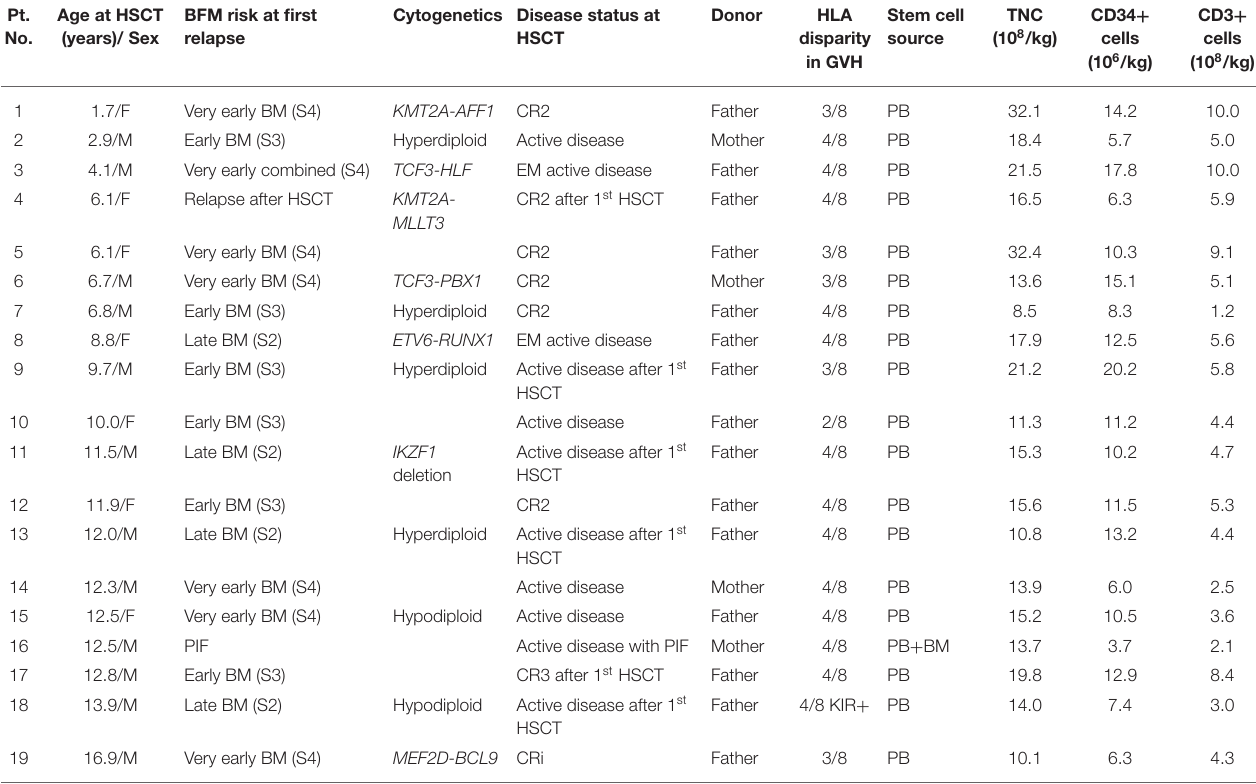
TABLE 1 | Patient, donor, and graft